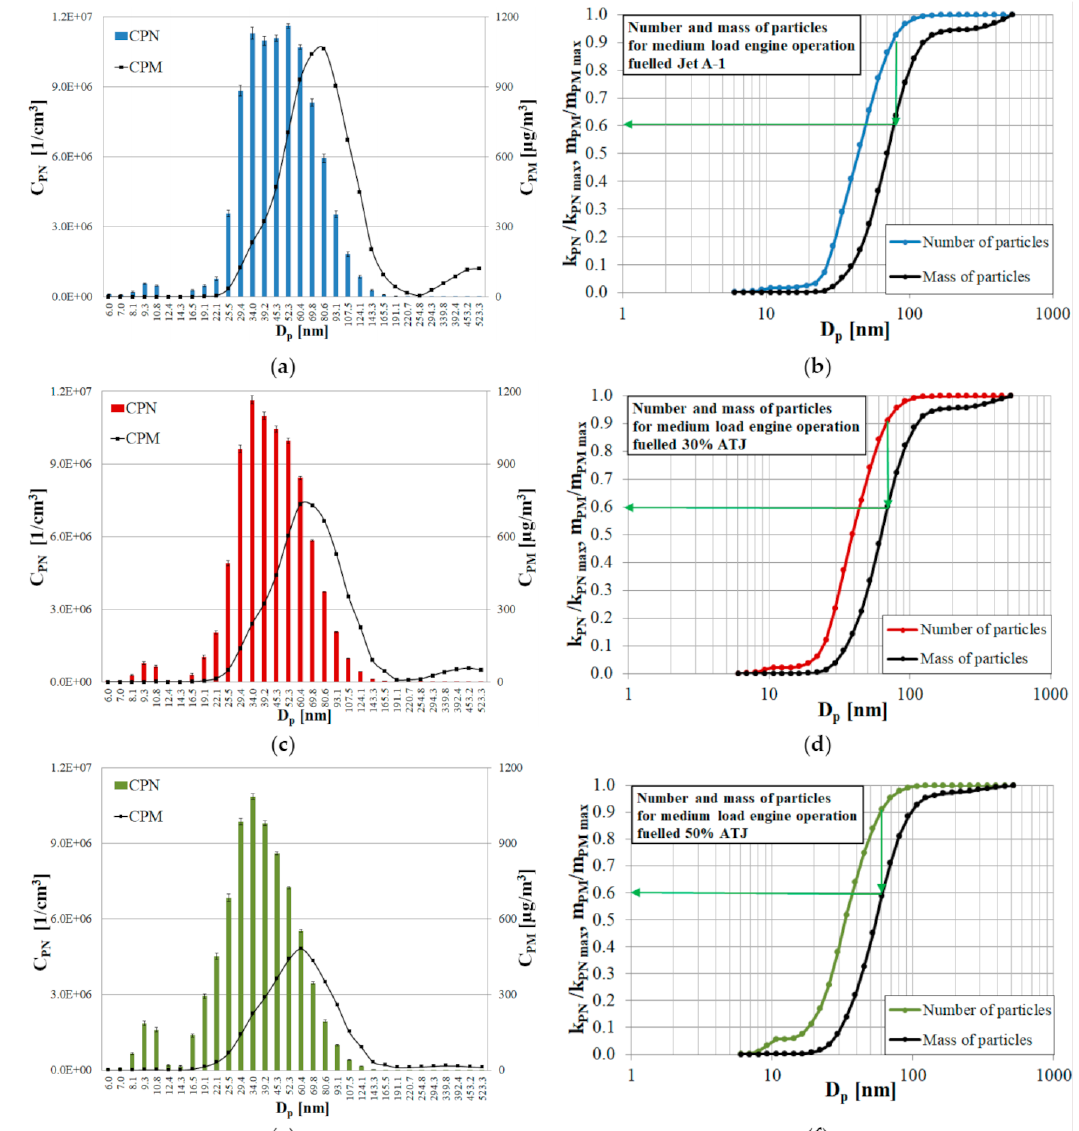
Figure 6. Number and mass concentration of particles depending on their diameter ( a , c , e ) and cumulative values of the relative particles number and relative mass of particulate matter ( b , d , f ) for medium engine operation load fueled Jet A-1 ( a , b ), 30% ATJ ( c , d ) and 50% ATJ ( e , f